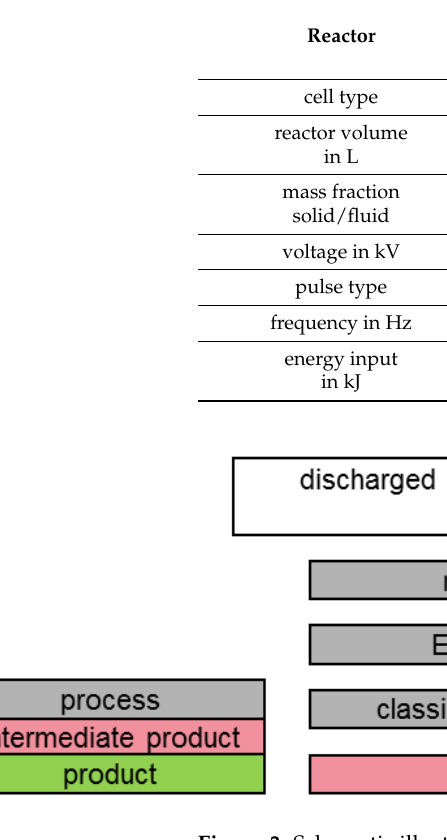
Figure 3. Schematic illustration of test series 1. Table 2. Overview of the EHF test parameters.